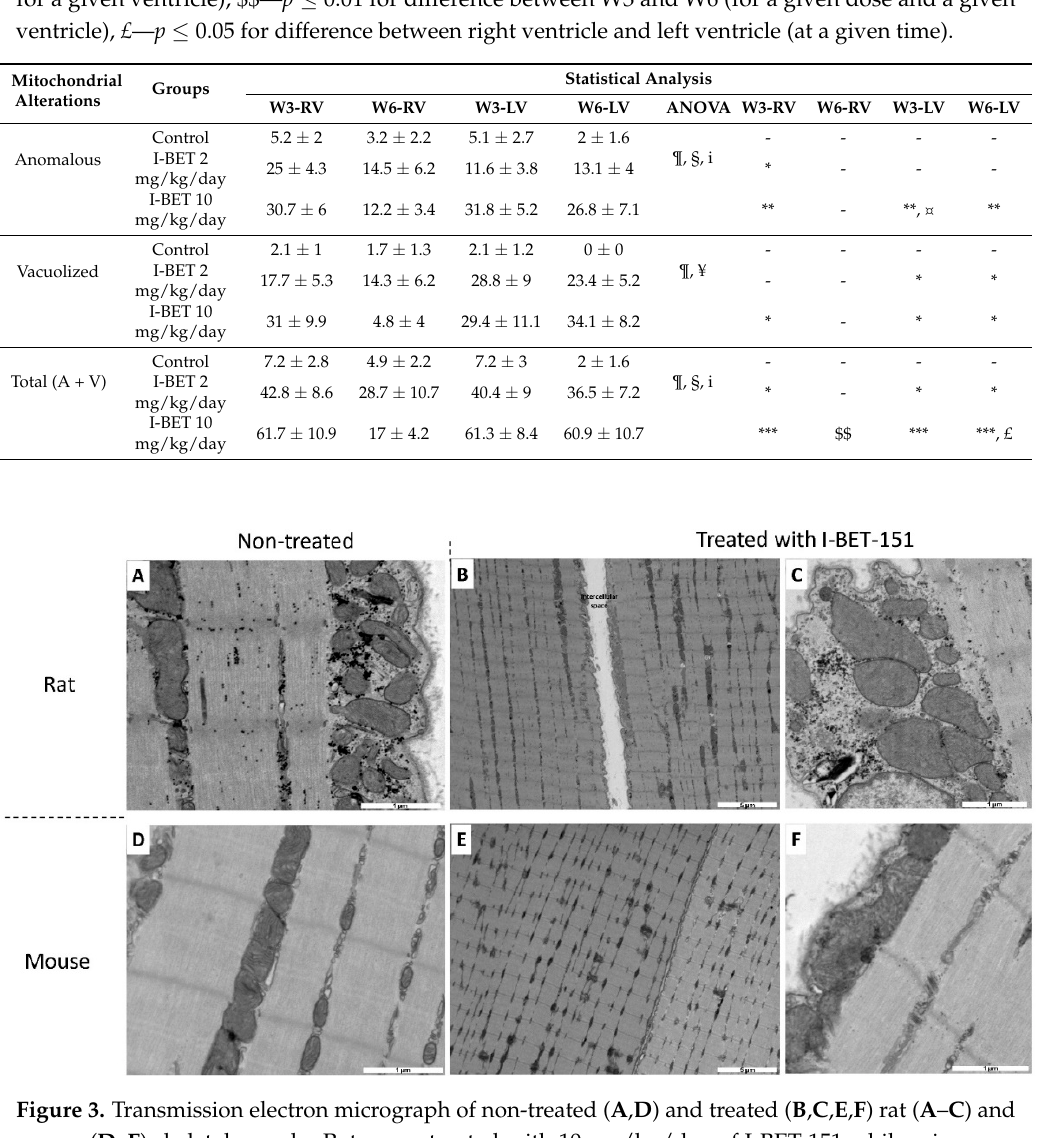
Figure 3. Transmission electron micrograph of non-treated ( A , D ) and treated ( B , C , E , F ) rat ( A – C ) and mouse ( D – F ) skeletal muscle. Rats were treated with 10 mg/kg/day of I-BET-151 while mice were treated with 50 mg/kg/day of I-BET-151. Bar scale is indicated on each micrograph. Selection of the most representative pictures from three animals per group.